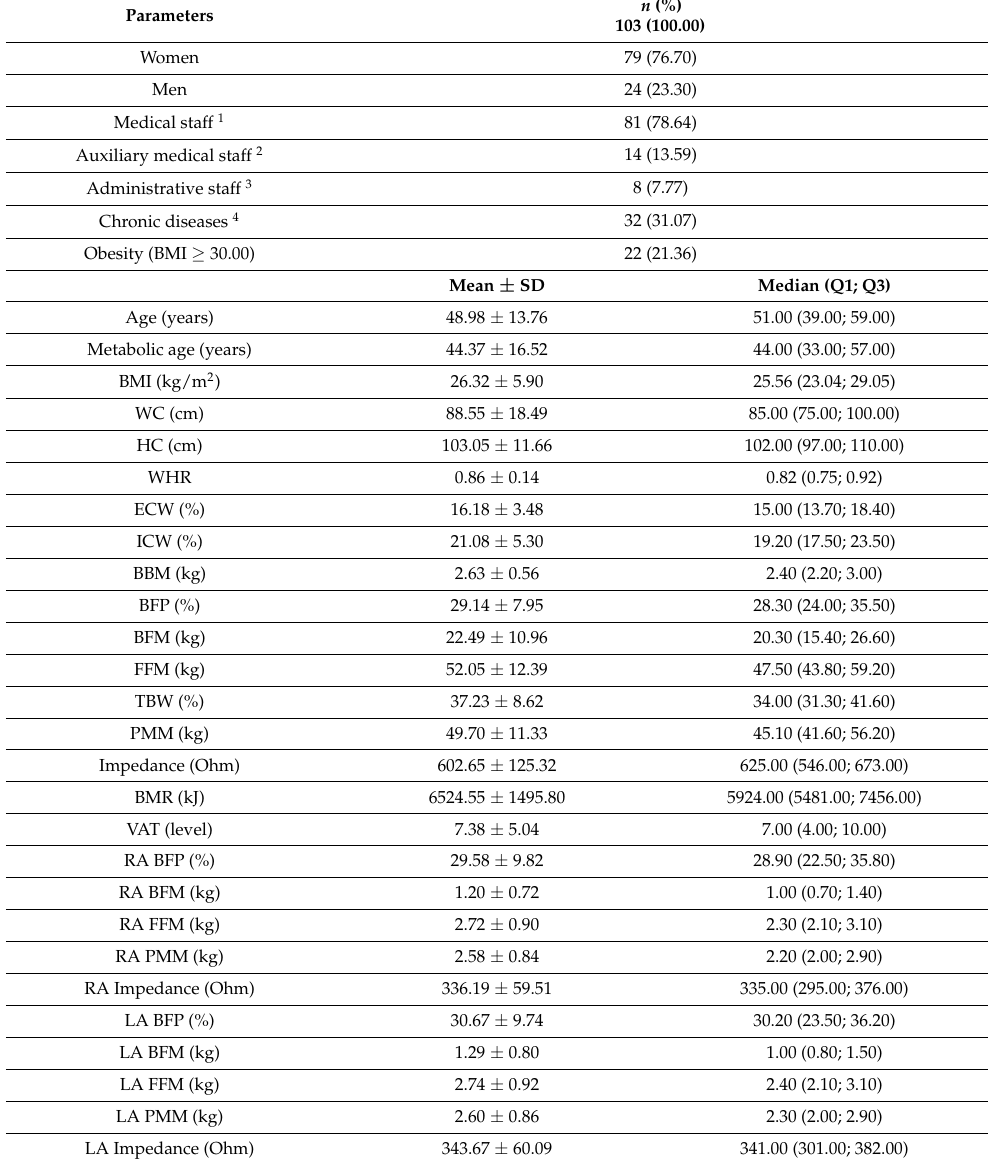
Table 1. Basic demographic and clinical characteristics of the study